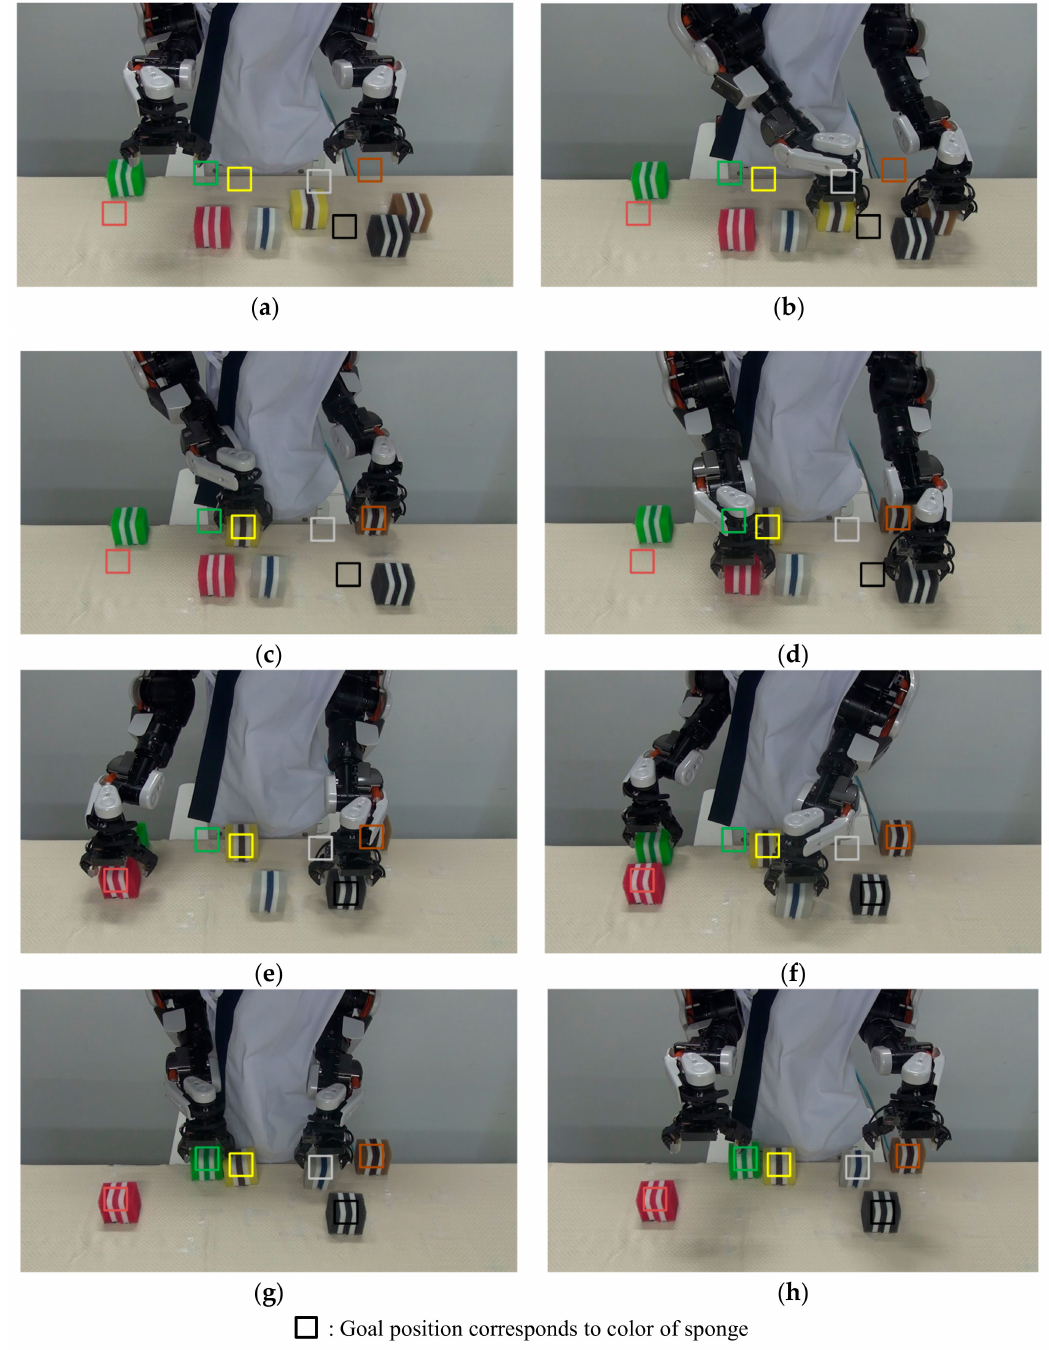
Figure 7. Verification Experiment 1: ( a ) initial configuration; ( b ) picking the yellow and brown blocks; ( c ) placing the yellow and brown blocks; ( d ) picking the red and black blocks; ( e ) placing the red and black blocks; ( f ) picking the green and grey blocks; ( g ) placing the green and grey blocks; and ( h ) final